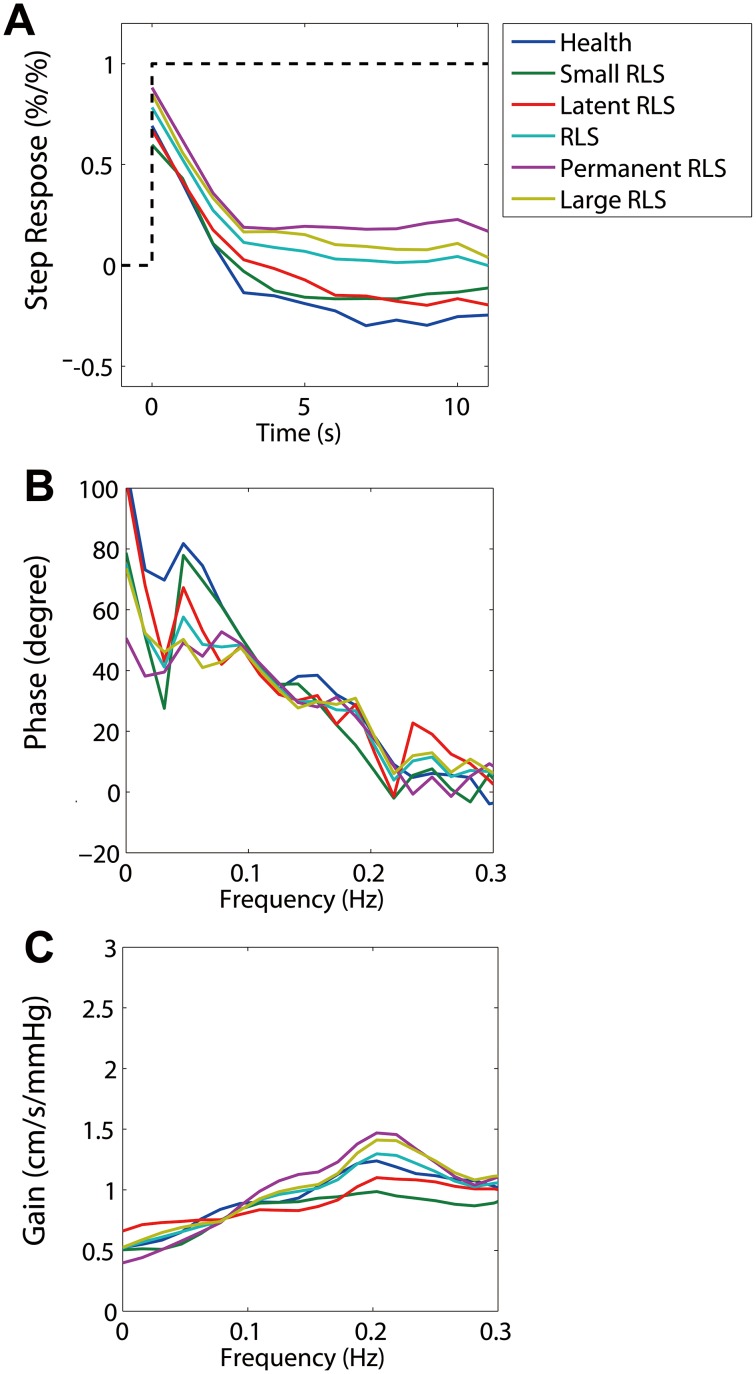
Three autoregulatory parameters derived from the transfer function.A) Step response, B) phase difference, and C) gain. Each colored line denotes an average parameter from each group. A) The dashed line is the unit step change to the transfer function, and the colored lines are responses derived from the transfer function for different groups. Both the step response and phase difference show that the best (quickest recovery from the step change and largest phase difference) dynamic cerebral autoregulation is displayed by the non-right-to-left shunt (non-RLS) group, and the worst (slowest recovery and smallest phase difference) is displayed by the large RLS group, whereas other groups are in between (statistical distribution of the parameters is shown in Figure 2).